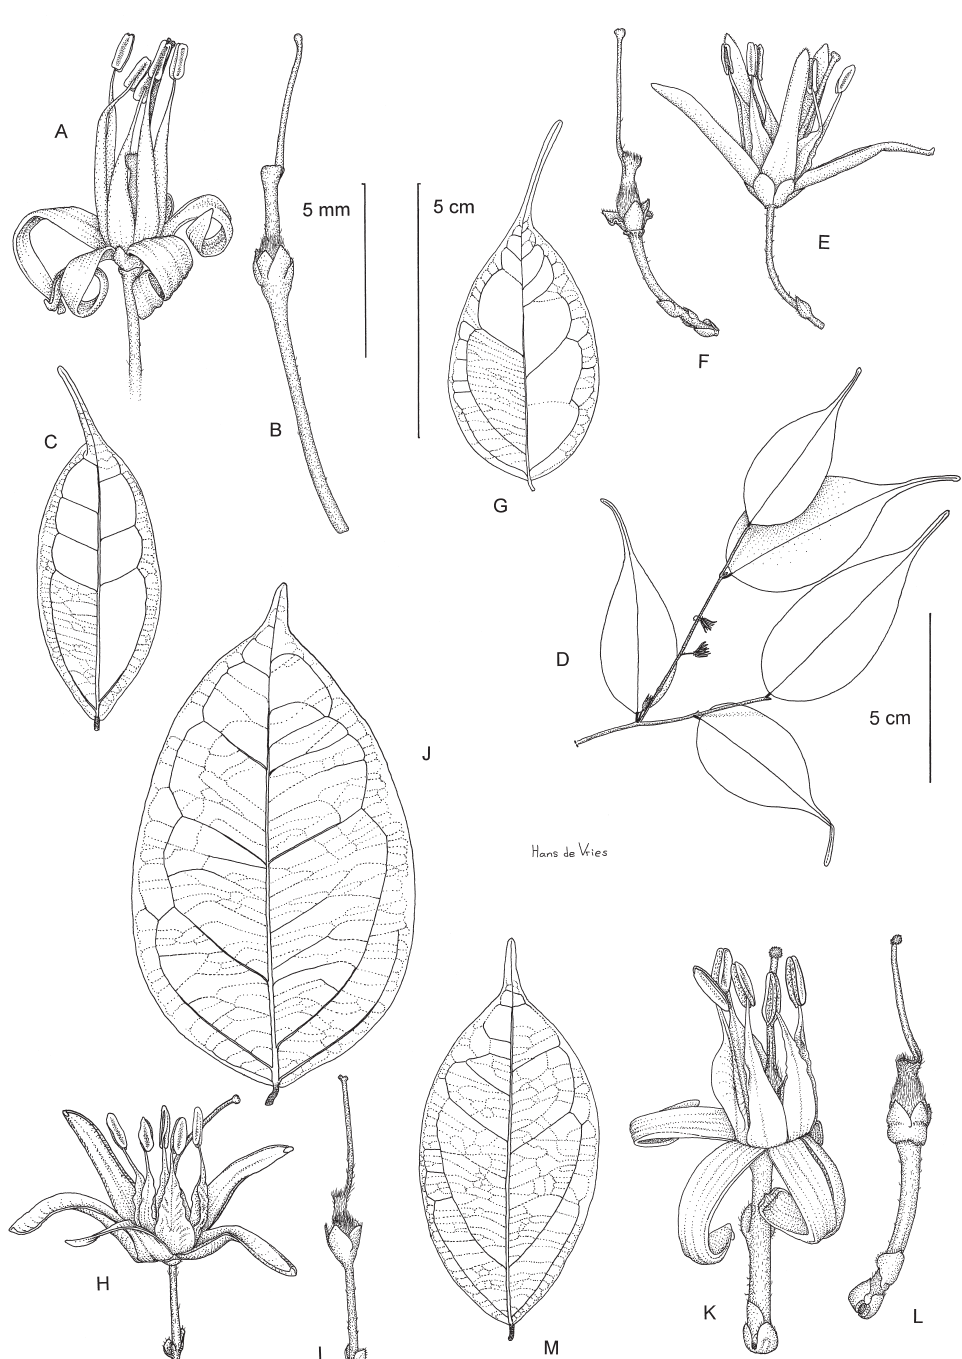
Fig. 1. A–C. Rhaphiostylis elegans Engl. A . Flower B . Flower without petals and stamens. C . Leaf. D–G . Rhaphiostylis minima sp. nov. D . Branch with flowers. E . Flower. F . Flower without petals and stamens. G . Leaf. H–M . Rhaphiostylis preussii Engl. H . Flower. I . Flower without petals and stamens. J . Leaf. K . Flower. L . Flower without petals and stamens. M. Leaf. All flowers are on the same scale (scale bar with B) and all single leaves too (scale bar with G). A–C from Tchouto & Elad 3310 (WAG), D–G from W.de Wilde 1061 (WAG), H–J from Beentje 1353 B from Ivory Coast (WAG), K–M from Breteler 14204 from Gabon (WAG). Drawn by Hans de